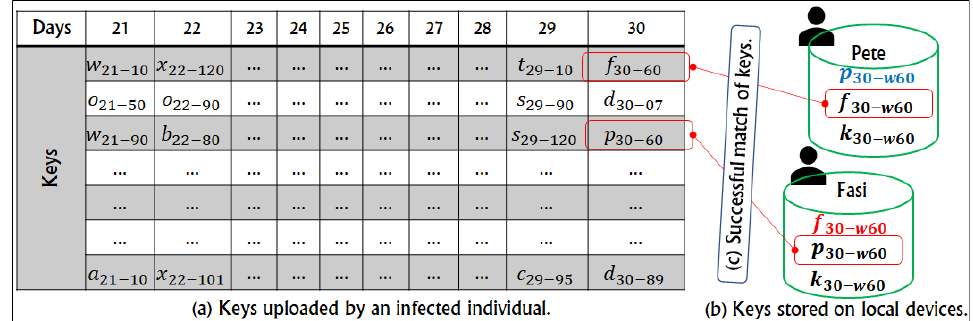
Figure 7. Example of checking key matches on local